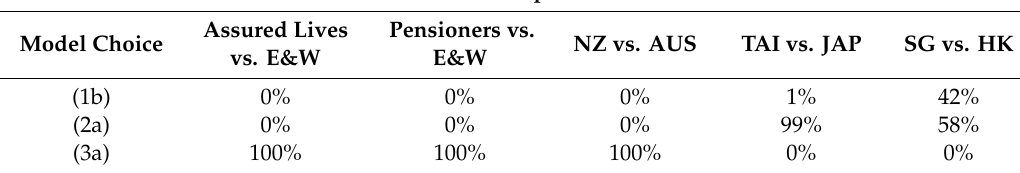
Table 5. Simulated proportions of model selections in modified semi-parametric bootstrapping for di ff erent